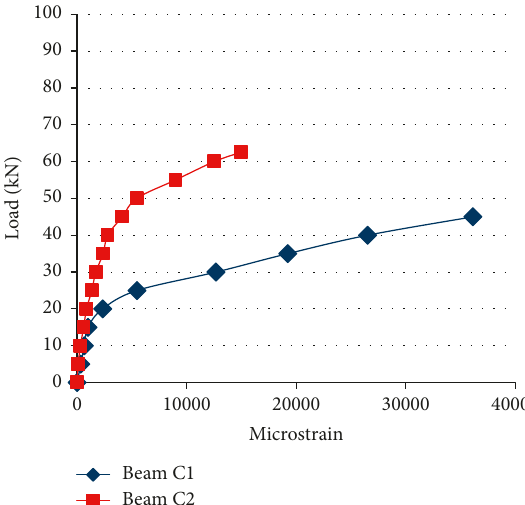
Figure 8: Effect of carbon fiber on load-strain response for beams having clear span �